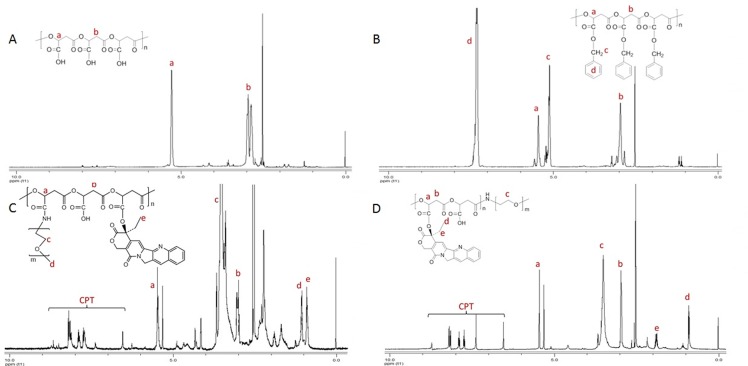
1HNMR spectra of PMLA(A), PMLABz(B), P1(C) and P2(D) (DMSO-d6, 500 MHz).